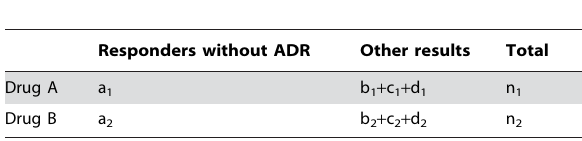
Table 3. Re-arrangement of results from Table 2 for calculating OR or